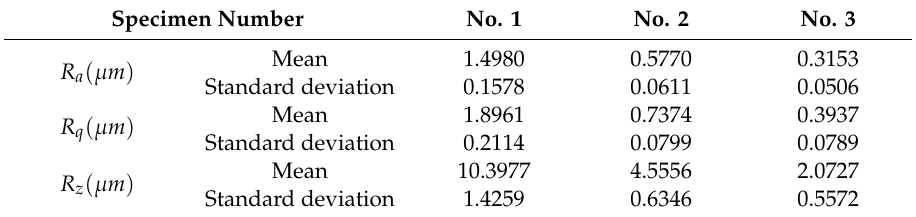
Table 1. Mean and standard deviation ( σ ) of surface roughness of tested